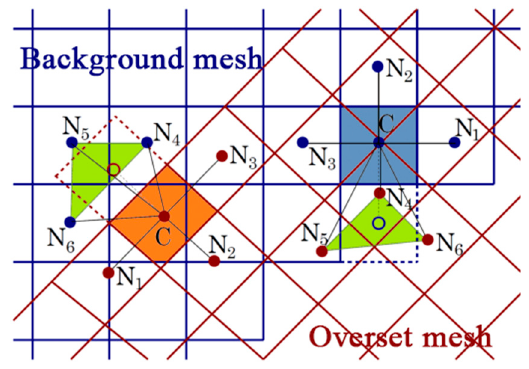
Figure 4. The schematic diagram of the overset mesh.